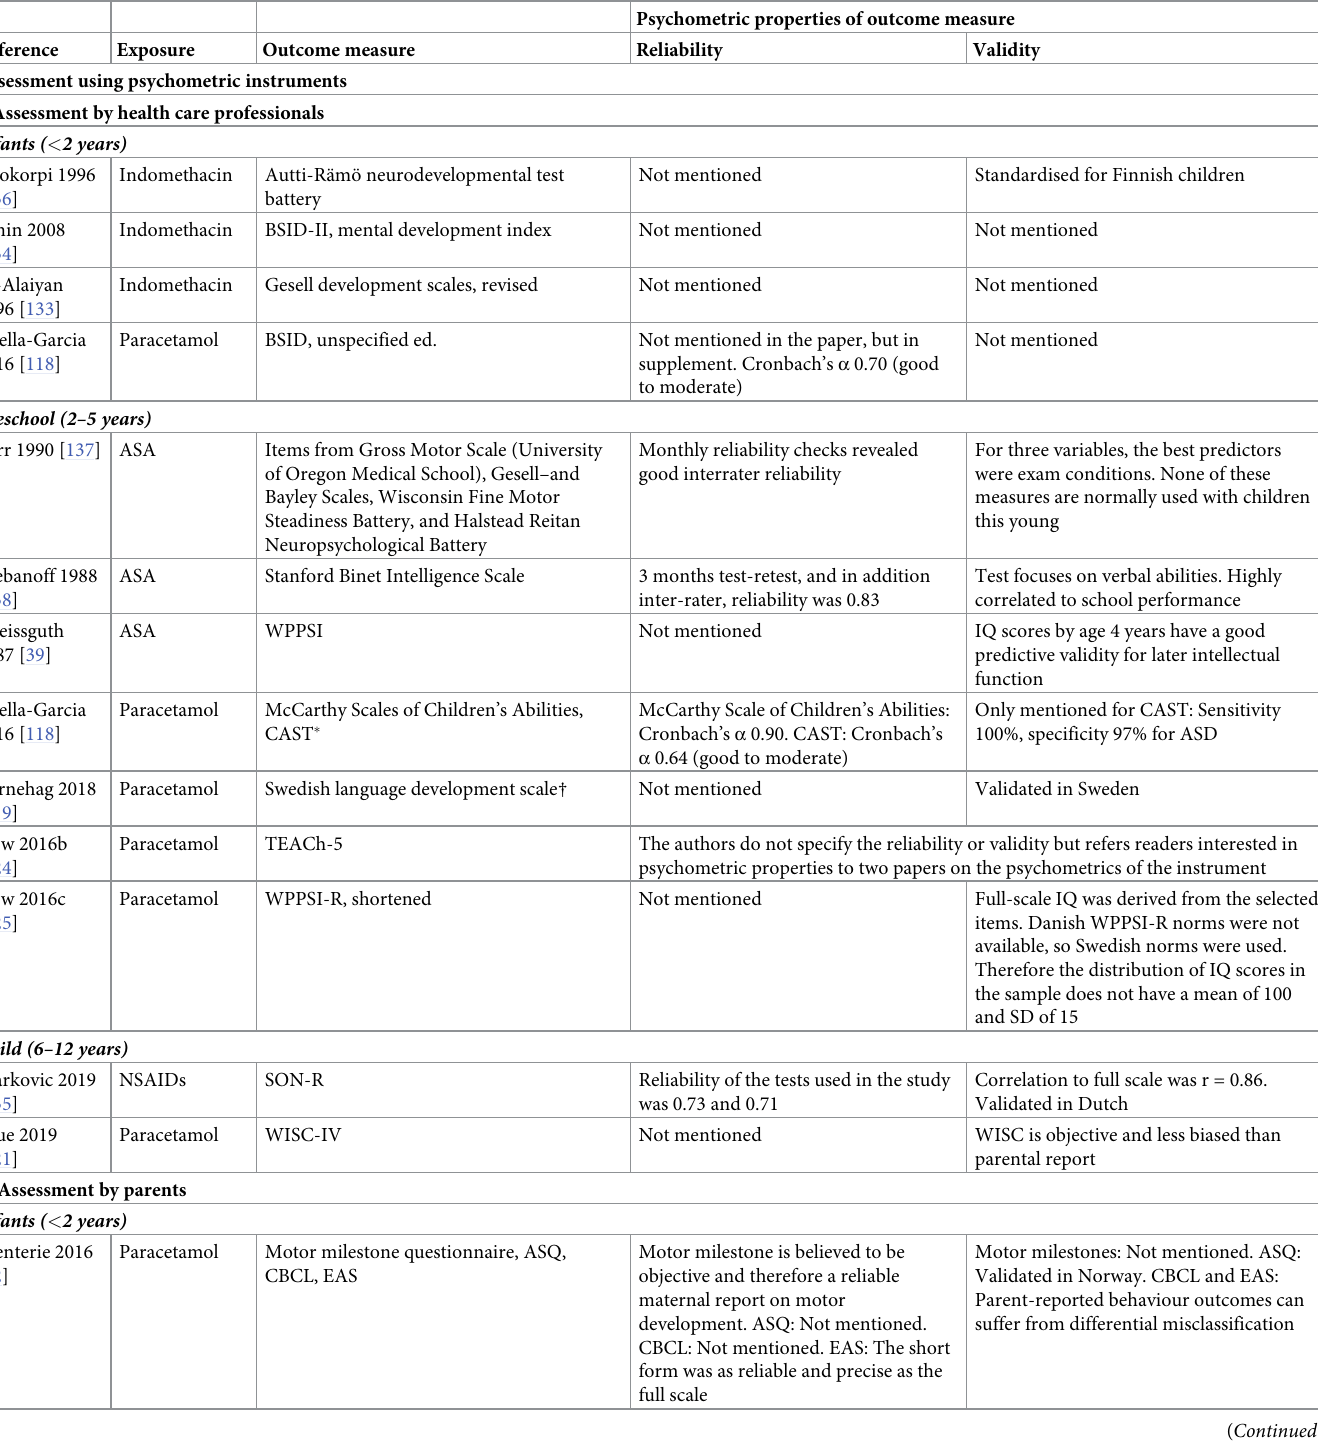
Table 3. Validity and reliability of outcome measures as reported by the authors of the study, papers on